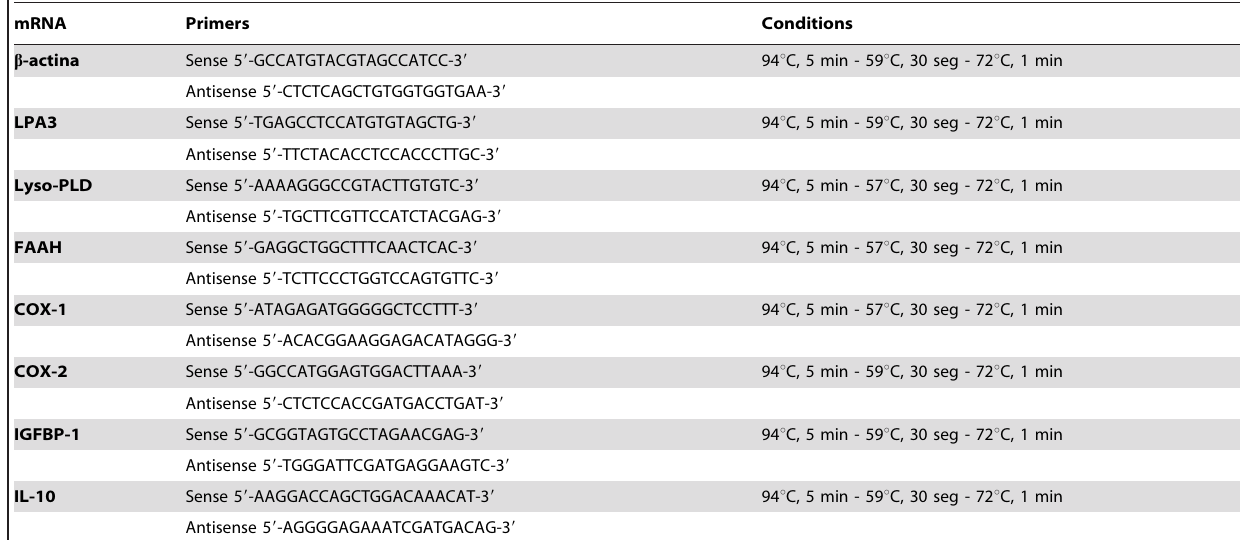
Table 1. RT-PCR primers and conditions.